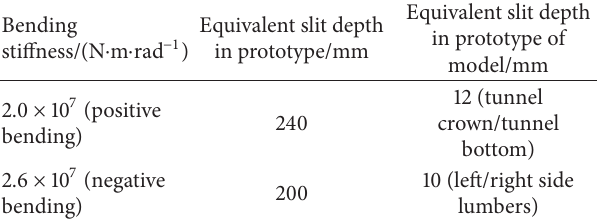
Table 3: Depths of slits in test